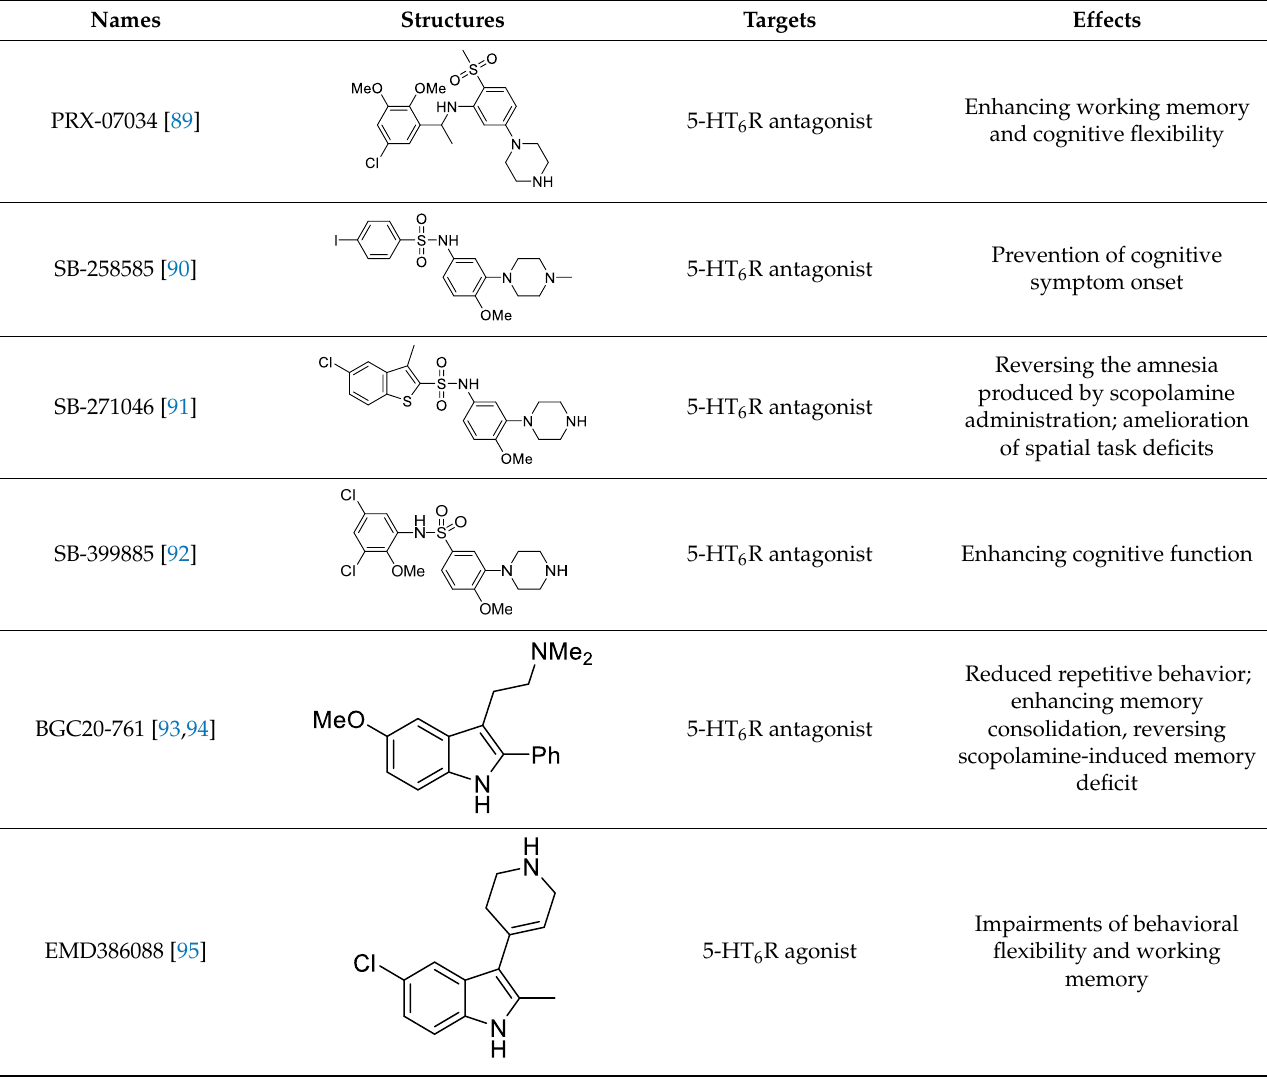
Table 3. 5-HT 6 R-targeted pharmacological agents which have potential effects on ASD treatment.